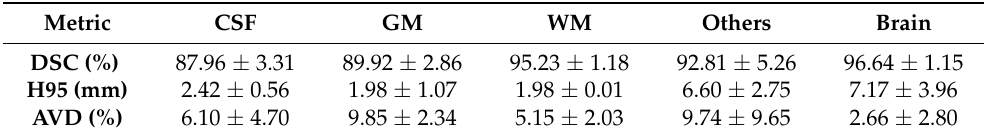
Table 1. Segmentation summary results, using DSC (%), H 95 (mm), and AVD (%). Results represent µ ± σ values.